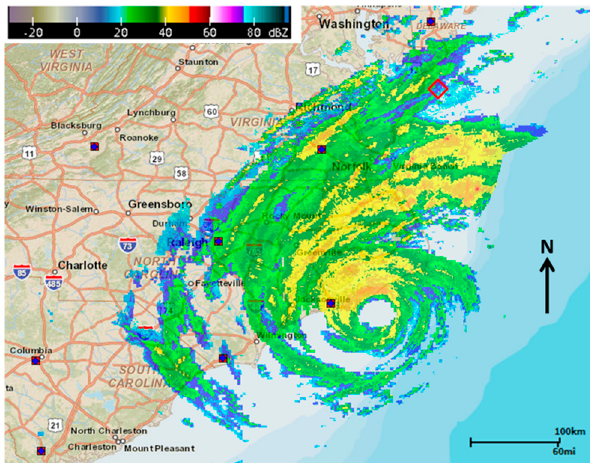
Figure 1. Mosaic of reflectivity from the WSR-88D radars of Hurricane Dorian at 0900 UTC on 16 September 2019. The red diamond marker is the location of the surface instrumented site at NASA’s Precipitation Research Facility (PRF). The NPOL radar operated by NASA is 38 km north of the NASA Precipitation Research Facility (PRF).